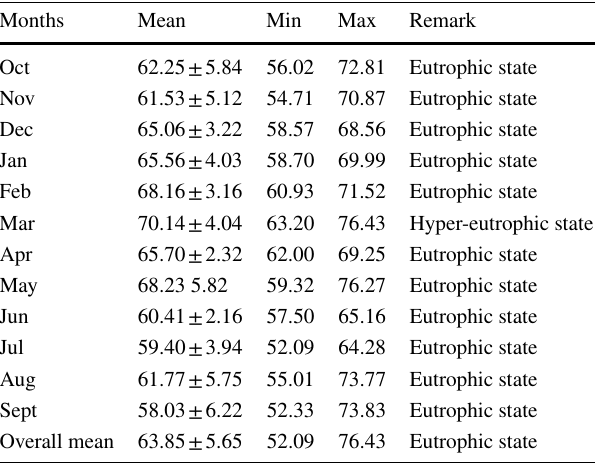
Table 7 Mean ± Std. Dev. and range of the CTSI across study sites Station Code